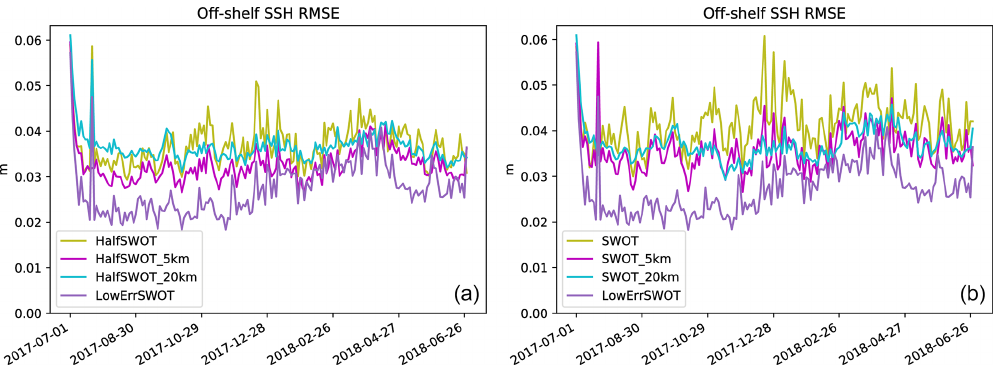
Figure 10. Off-shelf SSH RMSE for the HalfSWOT (a) and SWOT (b) experiments with the corresponding experiments where SWOT observations have been averaged over 5km and 20km radii. The LowErrSWOT experiment is also shown in both